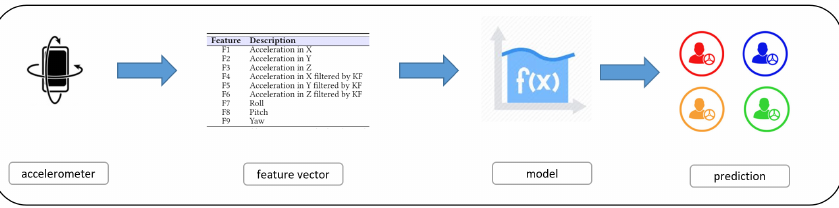
Figure 6. The Testing